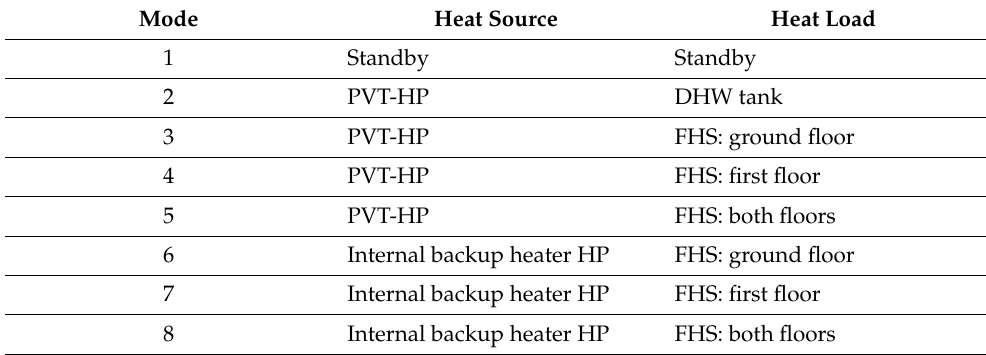
Table 12. Operating modes of the PVT-HP